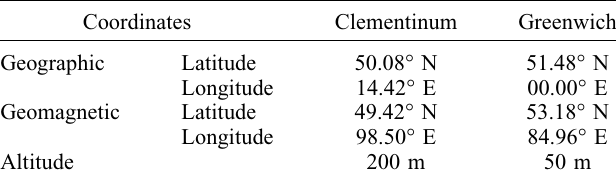
Table 1. The coordinates of observatories Clementinum and Greenwich according to information on the web page of the International Service of Geomagnetic Indices. The geomagnetic latitude and longitude are the corrected geomagnetic coordinates referred to epoch